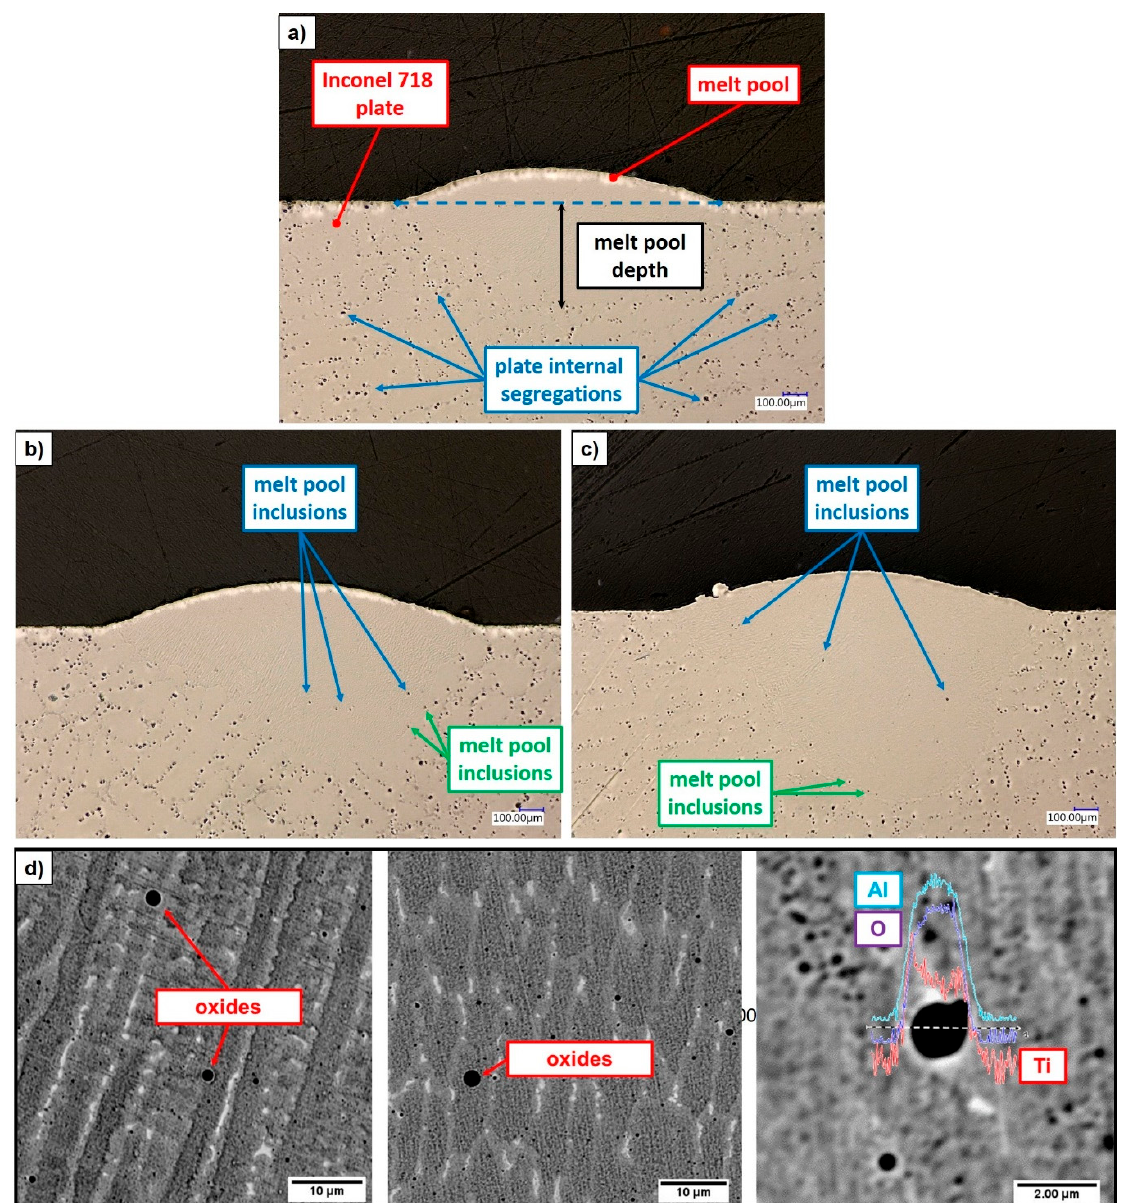
Figure 9. ST cross-sections: ( a ) 300 W, 300 mm/min; ( b ) 400 W, 300 mm/min; ( c ) 500 W, 300 mm/min; ( d ) detected Al/Ti-rich oxides in Inconel 718 as deposited material (SEM analysis) [31].